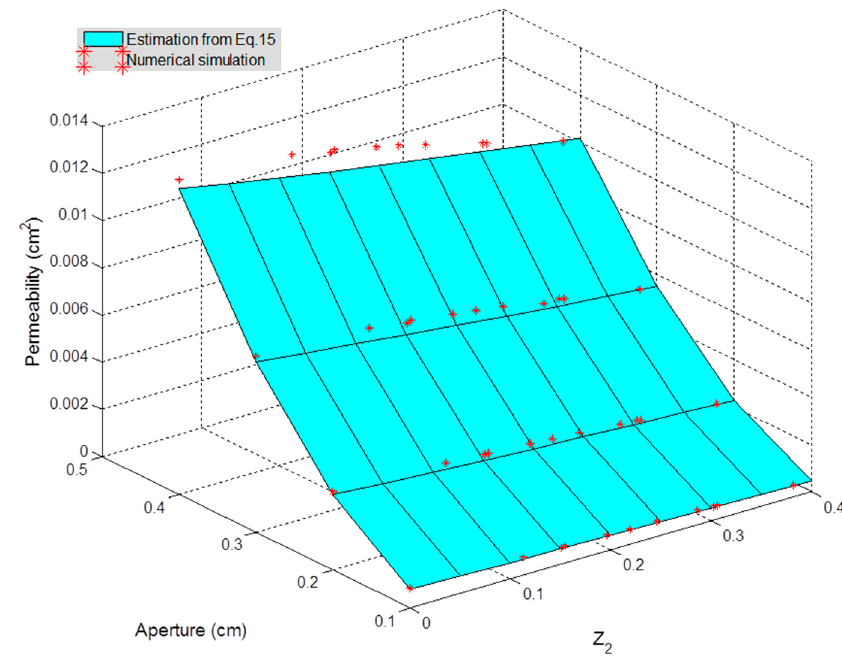
Figure 8. The relationship between Z 2 , aperture and permeability.